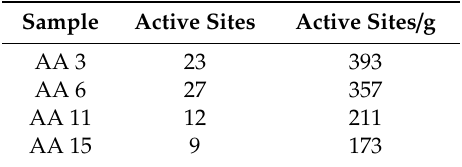
Table 13. Active site results of activated